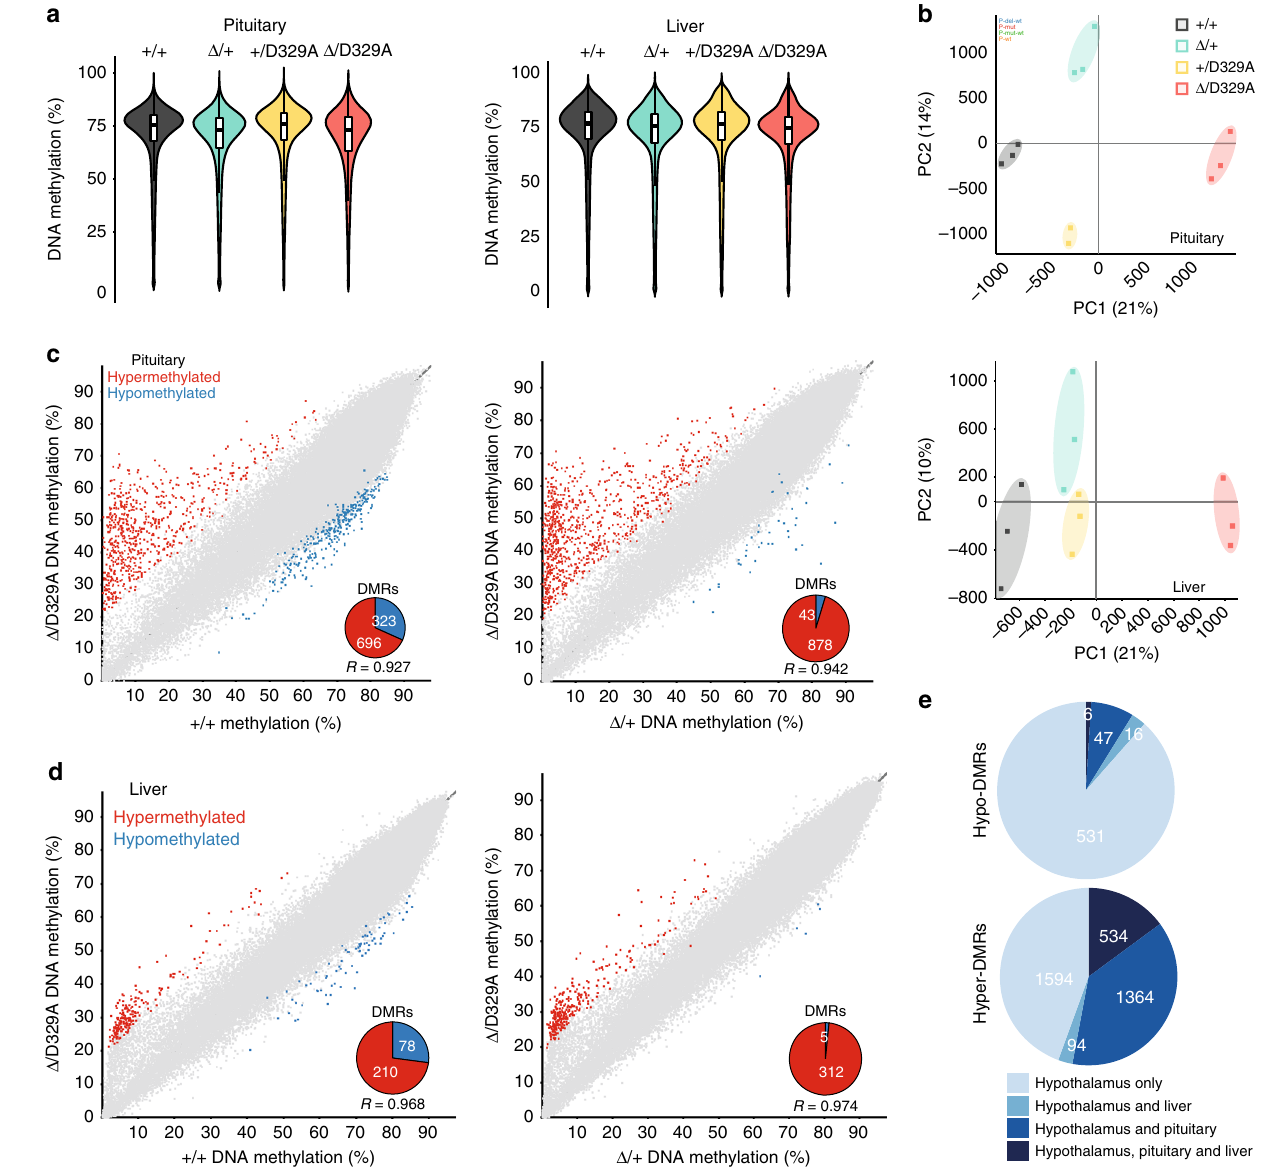
Fig. 3 DNA methylation in adult pituitary and liver. a Beanplots indicating whole genome methylation levels in pituitary and liver of 14-week adult male mice carrying the alleles shown. Tiles of 300 CpG positions. Boxplot shows median value and 25 – 75th percentiles, whiskers show lowest and highest observation, excluding outliers. Raw data are provided in Source Data. b PCA plots showing clustering of individual pituitary and liver samples into separate distant groups based on the genotype. c , d Scatterplots showing correlation between methylation levels of individual 300-CpG tiles in 14-week adult male ( c ) pituitary and ( d ) liver between Dnmt3a + / + and Dnmt3a Δ /D329A , and between Dnmt3a Δ / + and Dnmt3a Δ /D329A . Differentially methylated tiles were determined using the EdgeR proportion statistic in SeqMonk ( p < 0.01 corrected for multiple comparisons using Benjamini – Hochberg, methylation difference ≥ 20%). Pie-chart insets indicate how many of DMRs are hyper-methylated or hypo-methylated. e Pie charts showing how many hypo- methylated and hyper-methylated tiles in hypothalamus overlap the corresponding differentially methylated tiles in pituitary, liver or both. Pituitary and liver: tiles of 300-CpG position; hypothalamus: tiles of 100-CpG positions. In a – d , n (pituitary, + / + , Δ / + , Δ /D329A ) = 3, n (pituitary, + /D329A ) = 2,